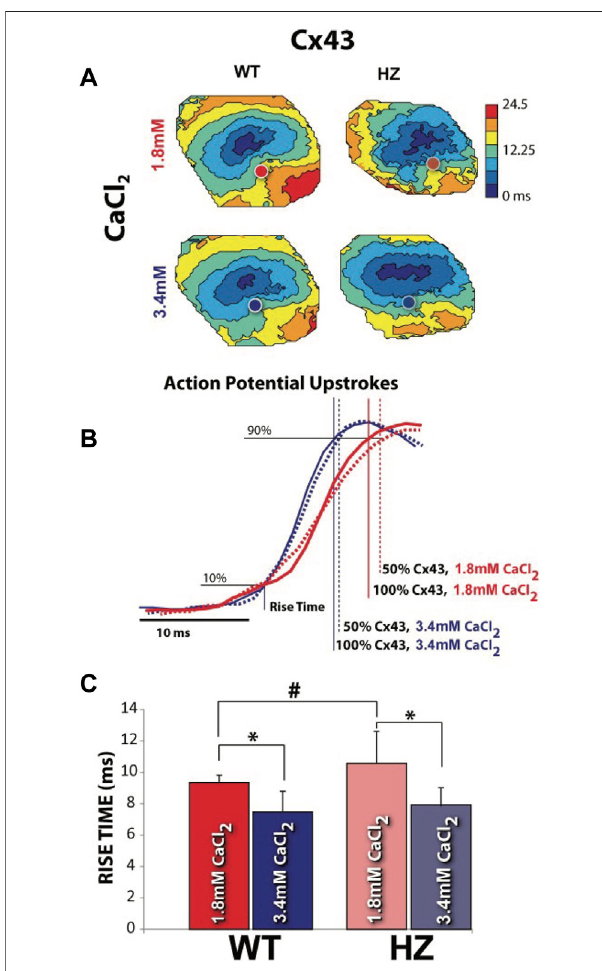
FIGURE7| Increasingextracellular[Ca 2+ ]toreduceperinexalwidth(W P ) increased CV and decreased AP rise time. (A) Representative isochronal maps of activation times, with circles indicating where the APs shown in (B) wererecorded.Closelyspacedisochronesindicateslowconduction. (B) Measurement ofrisetime during thedepolarization phaseofoptically mapped APs. Smaller W P during perfusion with high extracellular [Ca 2+ ] resulted in shorterrisetimesregardlessofGJcoupling.Signalshavebeentime-alignedat 10% of the total upstroke. (C) Average rise times for all WT and Cx43 HZ hearts perfused with normal and high levels of extracellular [Ca 2+ ]. * p < 0.05 with 2 tailed paired t -test, unequal variance. # p < 0.05 with 2 tailed unpaired t -test. ( n =4,WT,1.8 mMCaCl 2 , n =10WT3.4 mMCaCl 2 , n =5HZ, 1.8 mM CaCl 2 , n = 7 HZ, 3.4 mM CaCl 2